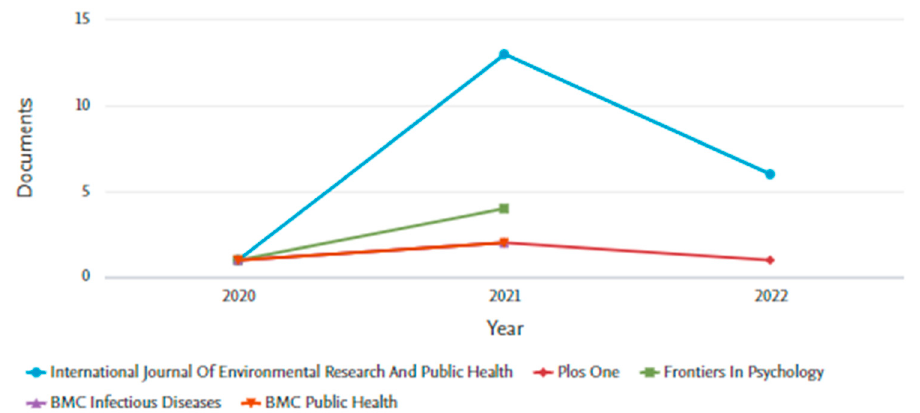
Figure 12. Journals with the highest number of publications—Scopus.